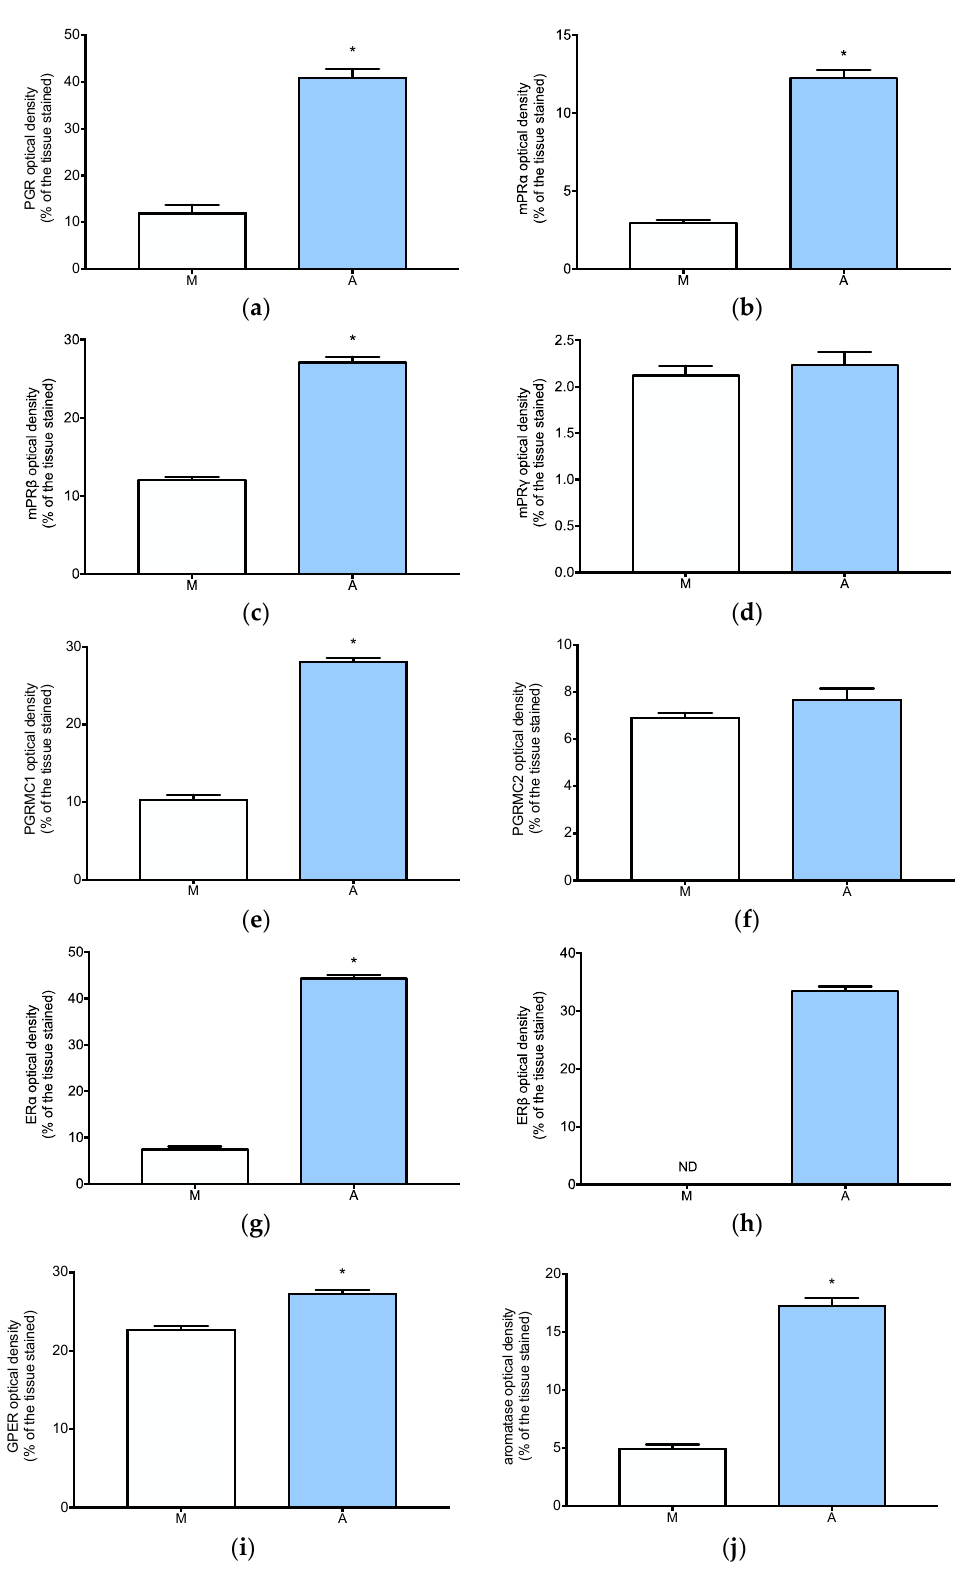
Figure A1. Quantification of IHC stainings in myometrium and adenomyosis tissues. Fiji (ImageJ) analysis of PGR ( a ), mPRα ( b ), mPRβ ( c ), mPRγ ( d ), PGRMC1 ( e ), PGRMC2 ( f ), ERα ( g ), ERβ ( h ), GPER ( i ) and aromatase ( j ). The columns represent the mean % of the tissues stained in the analysed fields. Asterisk indicates significant differences (* p ≤ 0.05). A, adenomyosis; M, myometrium.